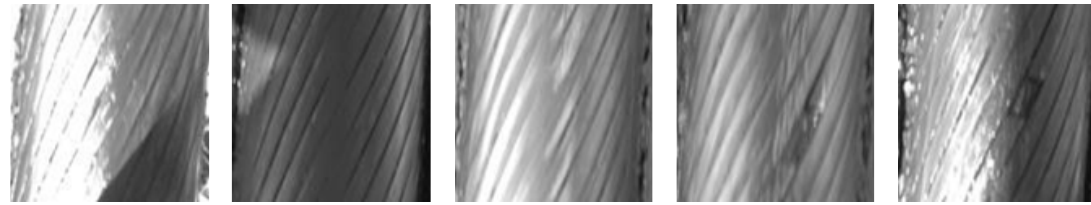
Figure 3. Real samples of wire rope images captured from hauling ropes.